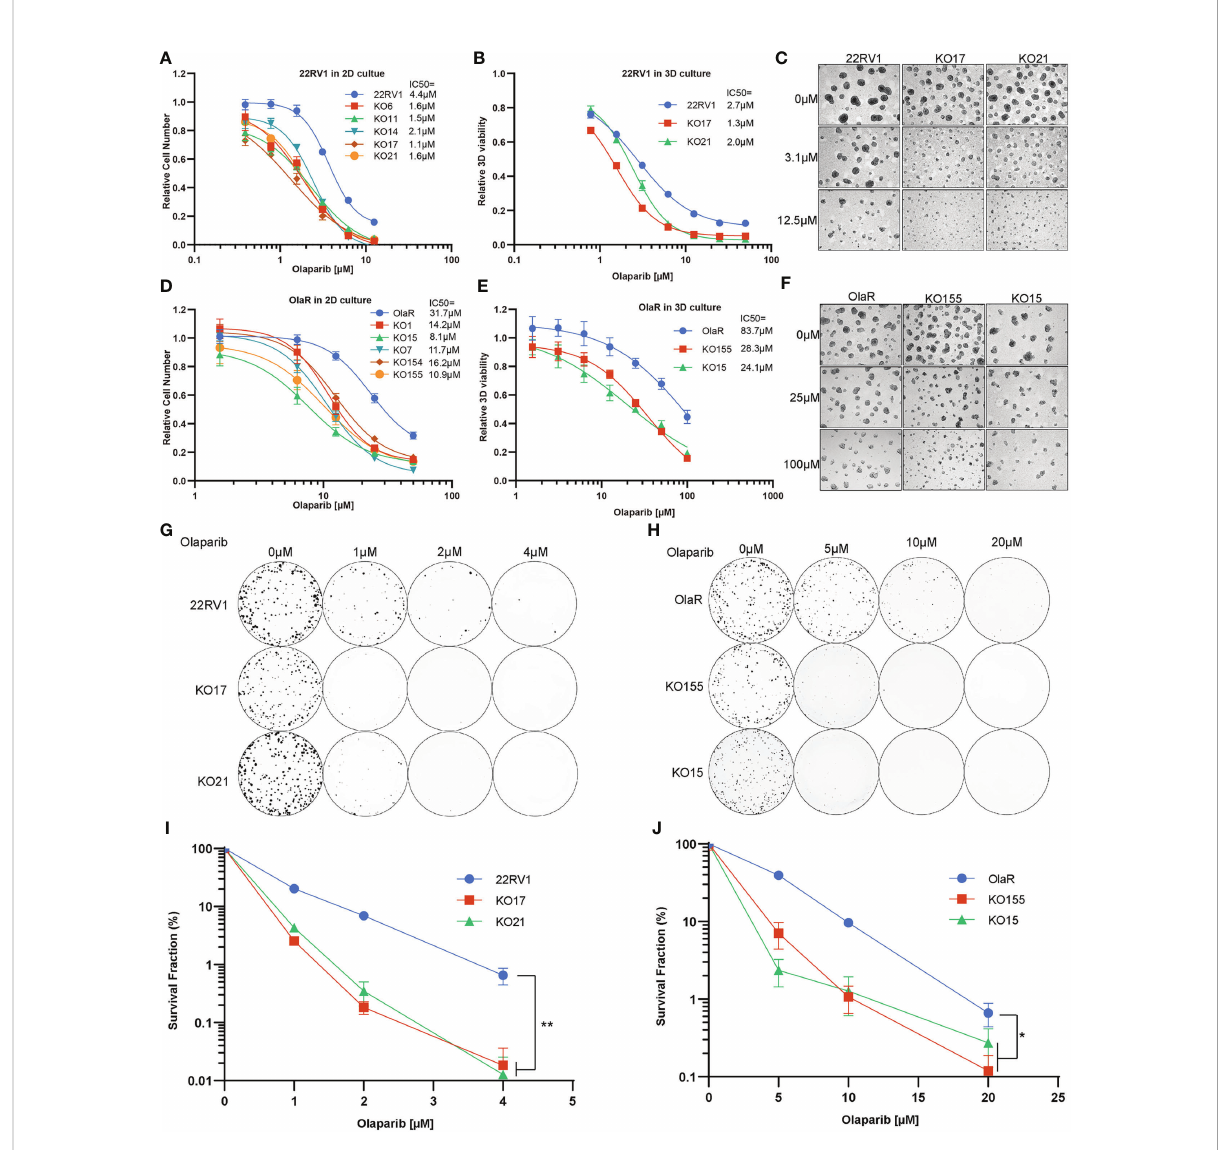
FIGURE 2 TBL1XR1 de fi ciency sensitizes prostate cancer cells to PARP inhibitor olaparib. (A – F) Increased sensitivity of TBL1XR1 KO cells in 22RV1 (A – C) and OlaR (D – F) cell lines after treatment with olaparib in 2D (A, D) and 3D (B, E) culture. Micrographs show images of growth assays for 22RV1 (C) and OlaR (F) in 3D culture. Data are mean ± s.e.m. normalized to untreated cells. Solid lines show a nonlinear least-squares fi t to a four- parameter dose-response model. (G – J) Reduced survival of TBL1XR1 KO cells in 22RV1 (G, I) and OlaR (H, J) cell lines after long-term treatment with olaparib. Data are mean ± s.e.m. normalized to untreated cells. *p < 0.05, **p <